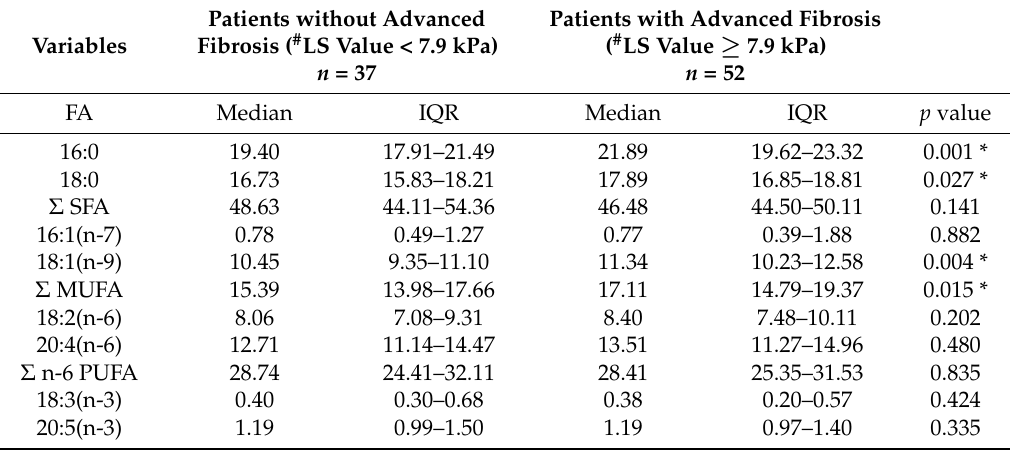
Table 2. Lipid composition of red blood cells (% of total fatty